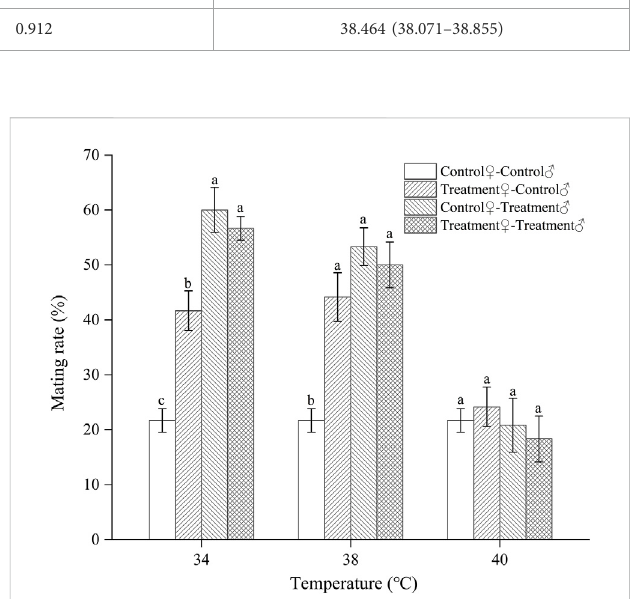
FIGURE 1 The mating rate of Z. tau individuals exposed to different high- temperature treatments for 12 h. Data are presented as the mean ± SE. Differentlowercaselettersabovethebarsindicatesigni fi cantdifferences between different mating combinations at the same temperature ( p < 0.05). No mating occurred within 24 h after the individuals were exposed to 42 ° C for 12